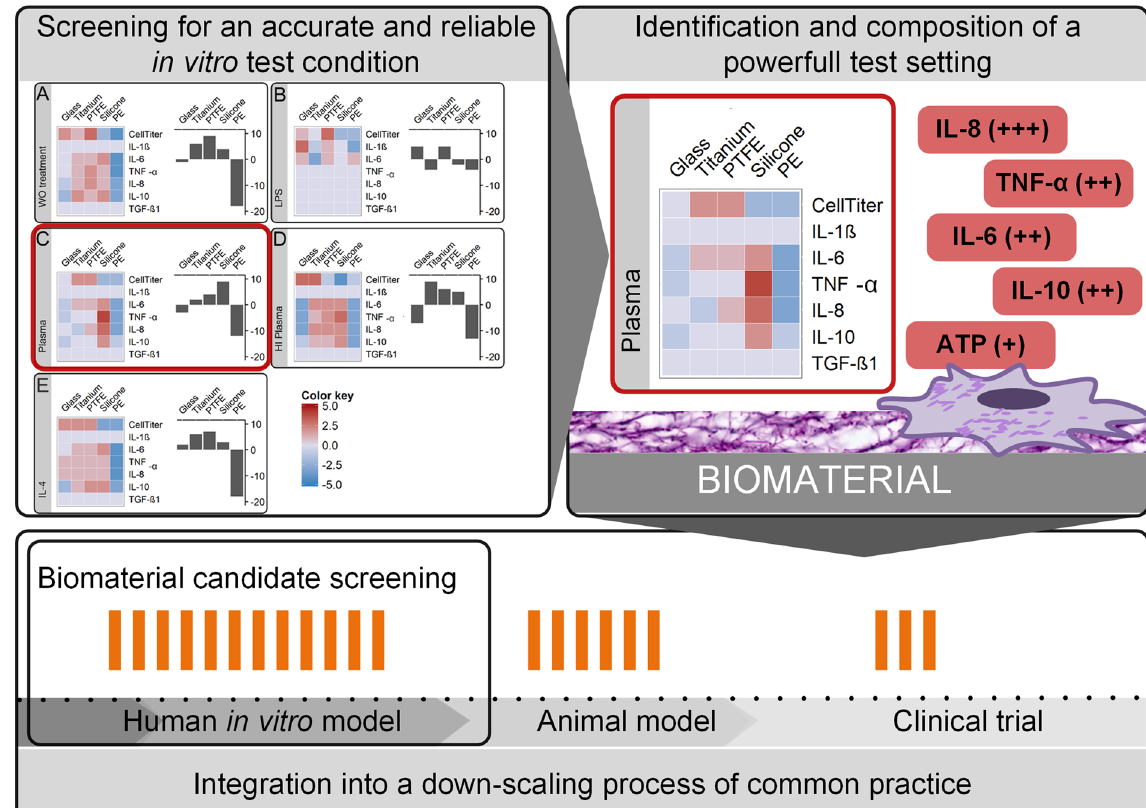
Figure 9. The integration of human-based in vitro test models into a down-scaling process of common practice is often neglected. One major flaw is a low correlation of in vitro tests to in vivo studies. In this study we propose a procedure to overcome this hurdle. In a large-scale in vitro screening approach, we identified an accurate and suitable condition for biomaterial testing and proved its validity by correlation to a well-described effect-the fibrotic progression - observed in vivo . On basis of this screening approach a well-defined in vitro test setting with a high predictive power was composed of (I) plasma pretreatment of biomaterials’ surface and (II) a set of highly predictive readout factors. We hope that the obtained data justifies a down-scaling of the in vitro test procedure to the identified condition and will be applied for large-scale biomaterial candidate screenings in following studies. Finally, followed by current common practice to study promising candidates in systemic animal models, and carrying the positively-proofed biomaterials in human